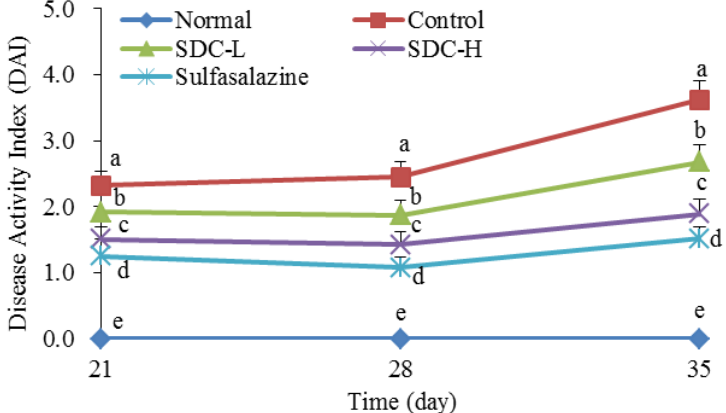
Figure 11. Disease activity index of mice with colitis. a–e Mean values with different letters in the same day indicate significant difference ( p < 0.05). SDC-L: 2 g/kg Shuidouchi extract treatment; SDC-H: 4 g/kg Shuidouchi extract treatment; Sulfasalazine: 20 mg/kg sulfasalazine treatment.